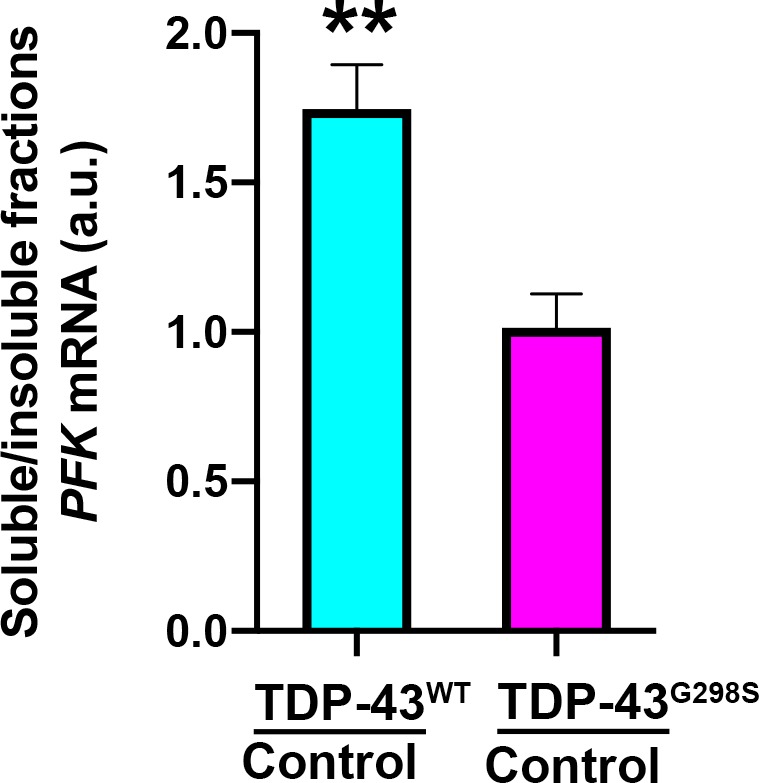
Cellular fractionations from third instar larvae.TDPWT (A) or TDPG298S (B) were fractionated (see supplemental materials and methods above) and PFK transcript levels in the urea fraction were quantified and normalized to controls (w1118). Wilcoxon ranked sum test was used to perform statistics.10.7554/eLife.45114.030Figure 7—figure supplement 1—source data 1.Soluble fractionations.